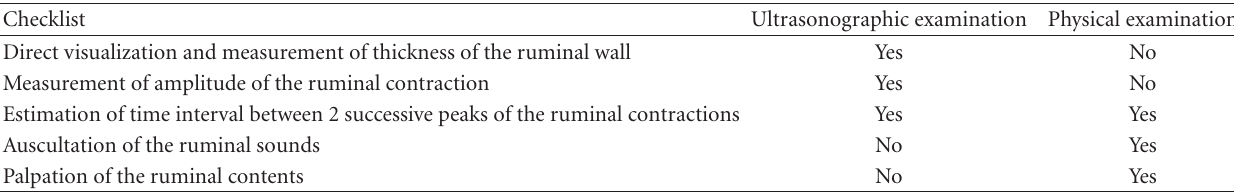
Table 1: Comparison between ultrasonographic and physical examinations of the